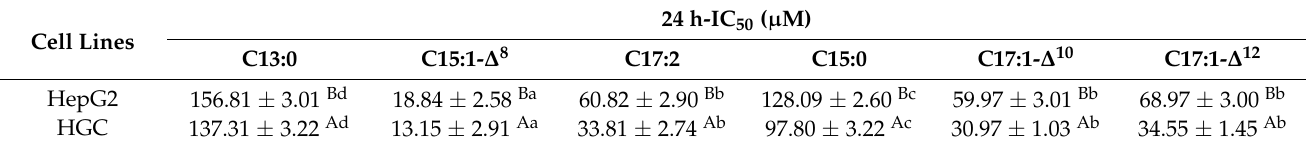
Table 3. Inhibition effects of the ginkgol compounds on the HepG2 and HGC